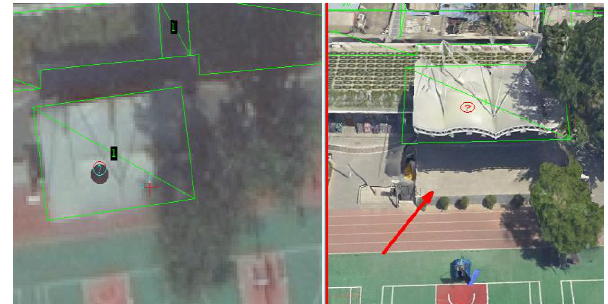
Figure 4 . Attribute accuracy.